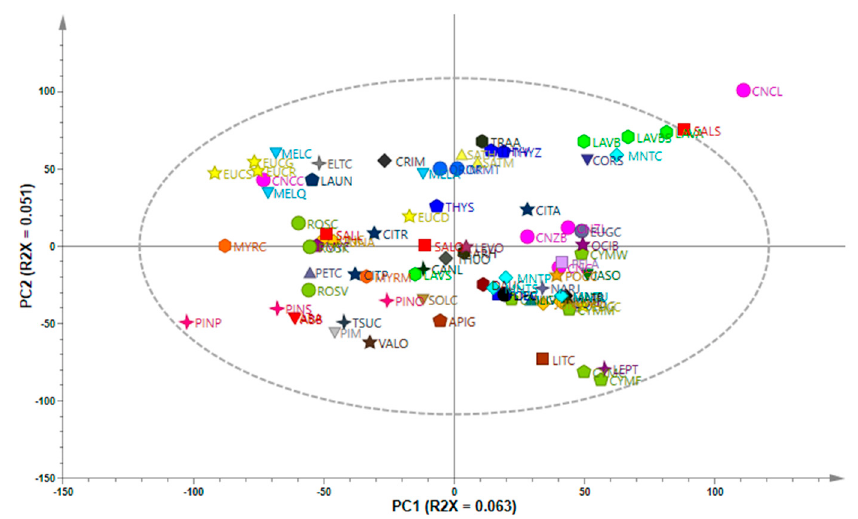
Figure 1. PCA scores scatterplot showing chemical variation in the essential oils based on GC-MS data. MS data.